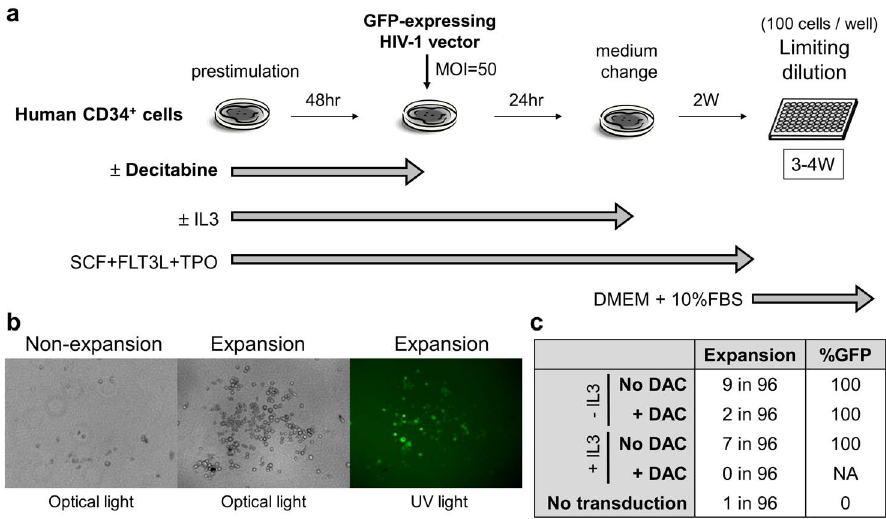
Figure 5. Decitabine reduced subclonal expansion of transduced CD34 + cells. (a). We performed a limiting dilution of human CD34 + cells which were transduced with lentiviral vectors after 48-hour decitabine exposure (0.5 m M), and then cultured in 96-well plates for 3–4 weeks to assay the expansion ability of transduced cells. (b). We detected subclonal expansion of GFP-positive cells that had originated from the transduced CD34 + cells. (c). The expansion rates were reduced by decitabine exposure under cytokine prestimulation without IL3 (2.1% vs. 9.4%) and with IL3 (0.0% vs. 7.3%). FBS: fetal bovine serum, NA: not applicable.